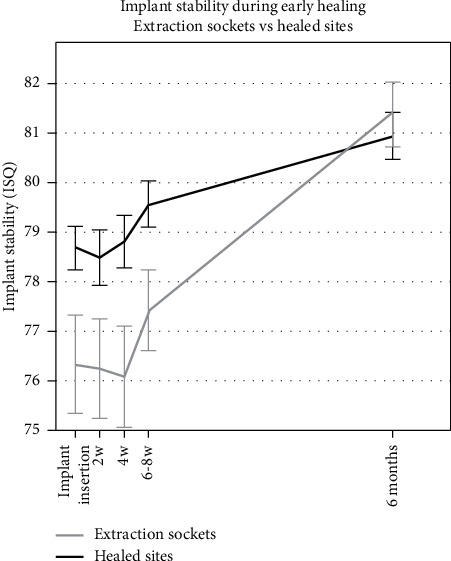
Time-stability curve for ISQ measurements comparing implants placed in healed sites and extraction sockets at the time of implant insertion, 2-, 4-, and 6 weeks, and 6 months. Error bars show the standard error of the mean (SEM).